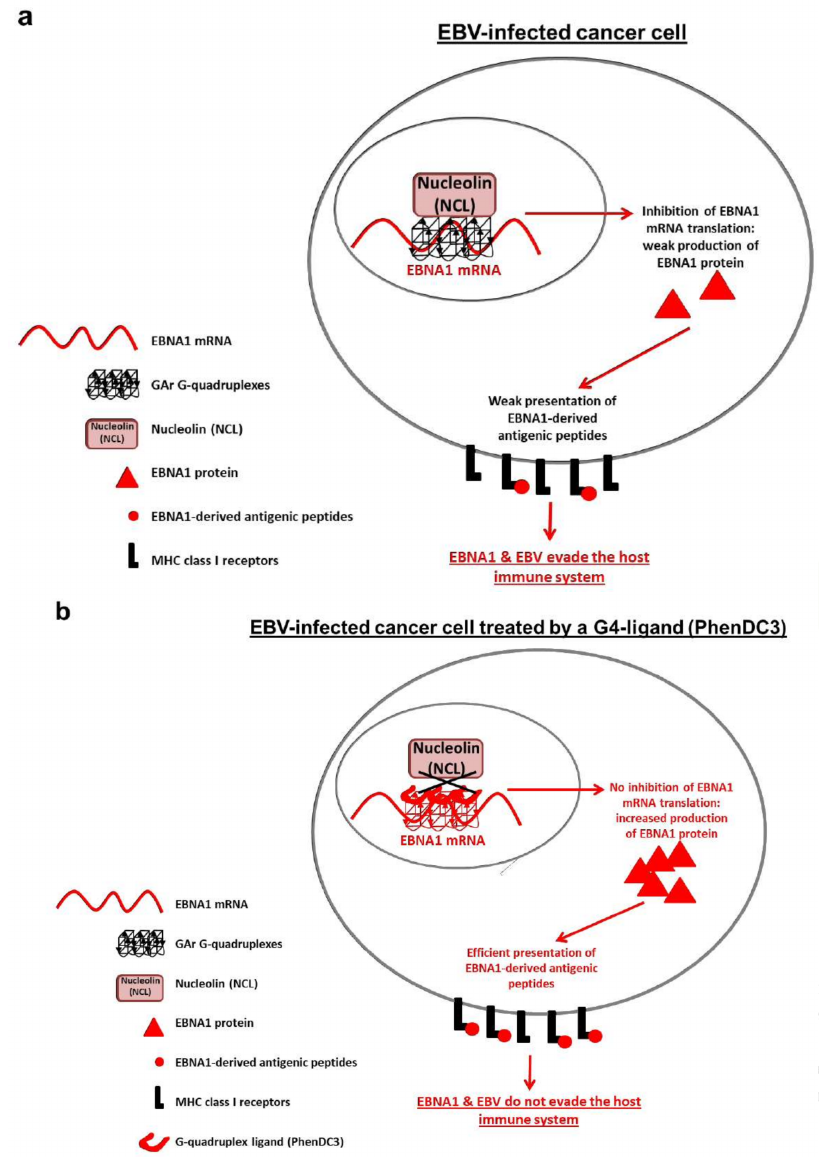
Figure 4. ( a ) Model of the role of nucleolin (NCL) in GAr-based inhibition of translation in cis. NCL binds directly to G-quadruplexes (G4) formed in the GAr-encoding sequence of EBNA1 mRNA, thus inhibiting its translation, thereby leading to weak production of EBNA1 protein and EBNA-derived antigenic peptides, which allow EBNA1 and EBV to evade the immune system. ( b ) Effect of the G4-ligand PhenDC3 on GAr-based inhibition of translation and antigen presentation. PhenDC3 binds to G-quadruplexes (G4) formed in the GAr-encoding sequence of EBNA1 mRNA, thus preventing the binding of NCL, thereby relieving the inhibitory effect of GAr on both translation and antigen presentation. Hence, the NCL-EBNA1 mRNA interaction is a relevant and druggable therapeutic target to unveil tumour cells from EBV-related cancers to the immune